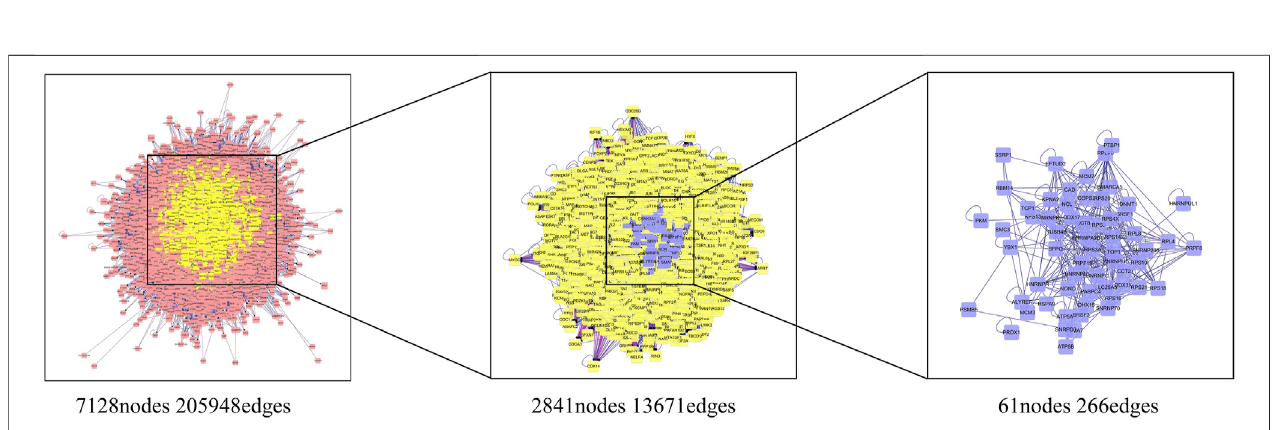
FIGURE 7 | Protein-protein interaction (PPI) network results for CVDs treatment of HJP.